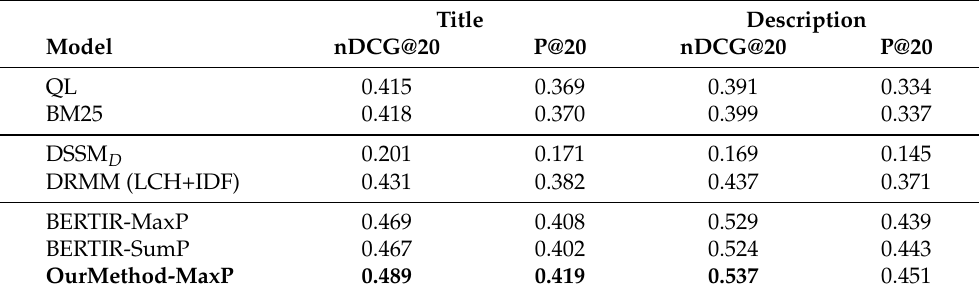
Table 4. Comparison on